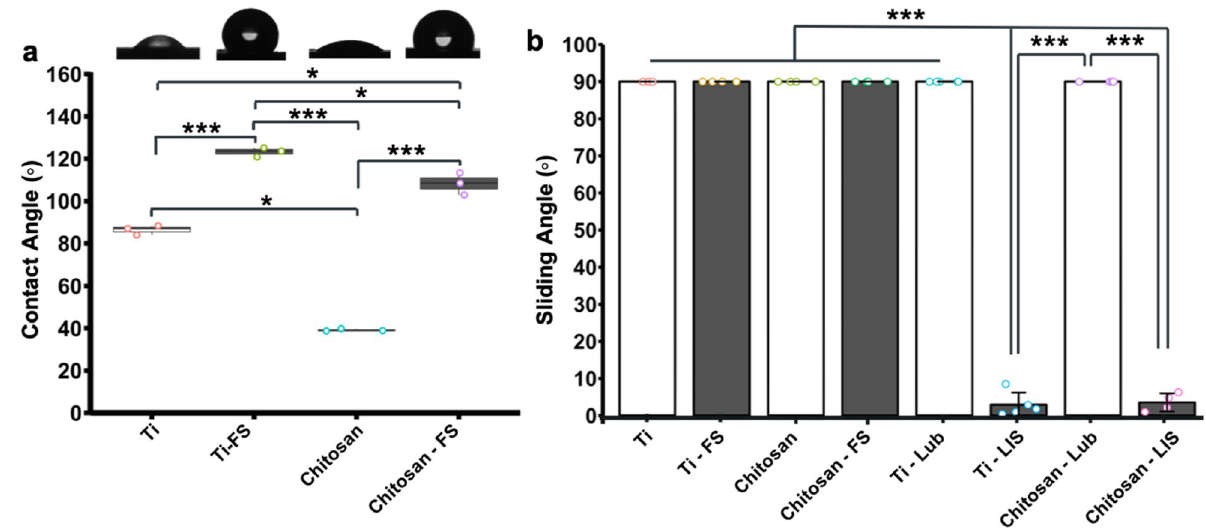
Figure 2. Surface Characterization. ( a ) Water static contact angle measurements on titanium and titanium coated surfaces. The morphology of the water droplet on each surface is shown on top of each bar. Part (a) was analyzed using a Kruskal–Wallis test followed by a Conover’s test to compare the mean rank-sum, with n = 3 for all groups. ( b ) Water sliding angle for the coated titanium surfaces, both bare or lubricated with PFPP. Part (b) was analyzed using a Kruskal–Wallis test followed by a Conover’s test to compare the mean rank-sum, with n = 4 for all groups with the exception for Ti-LIS and Chitosan LIS, which had n = 5 independent samples. Data points represent the mean, and error bars show the standard deviation. ‘***’ represent a p -value of P < 0.001, and ‘*’ represent a p-value of P <